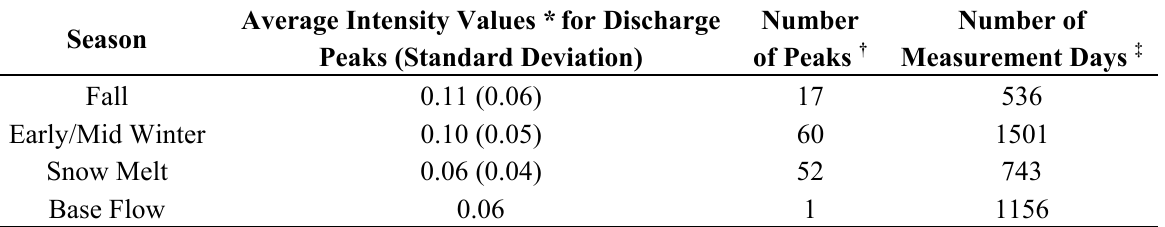
Table 4. Intensity values for discharge peaks (m 3 s − 1 ) by